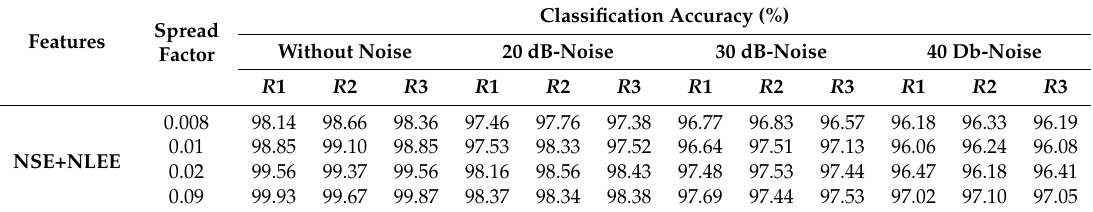
Table 8. PNN classification results at level 6 of wavelet packet decomposition using “db20” during noisy conditions.